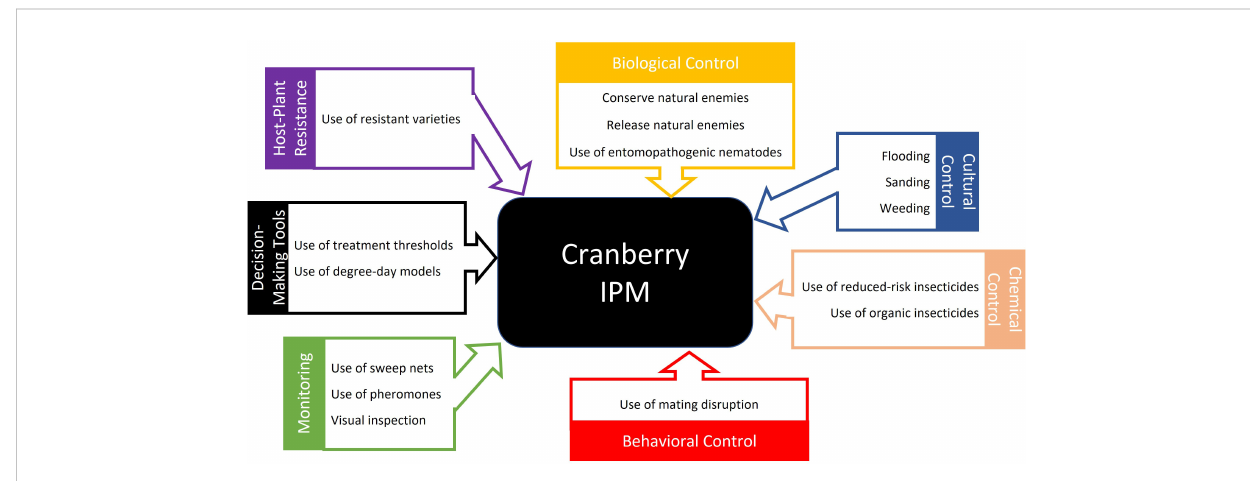
FIGURE 8 Summary of advances in integrated pest management (IPM) strategies for cranberry